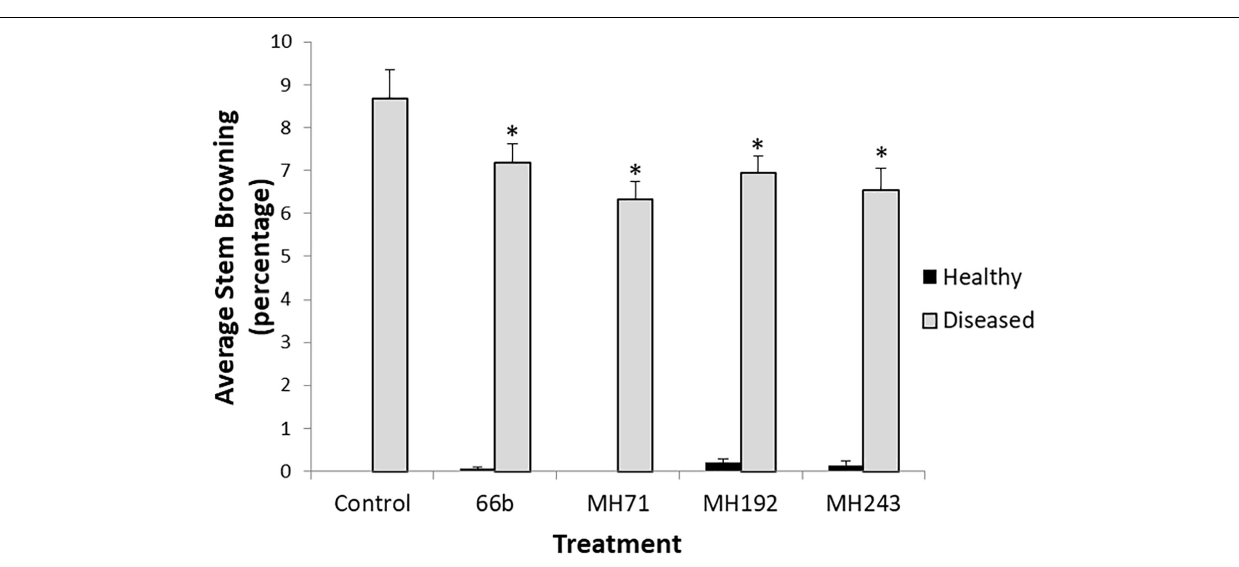
FIGURE 8 | Disease severity (% stem browning) at maturity in the glasshouse experiment. ∗ Indicates significant difference ( P < 0.05) between the disease control and disease infected plants treated with Actinobacteria seed coats. Healthy plants received the same Actinobacterial seed coat treatments (or plain xantham gum coating for controls) but were not challenged with F. pseudograminearum